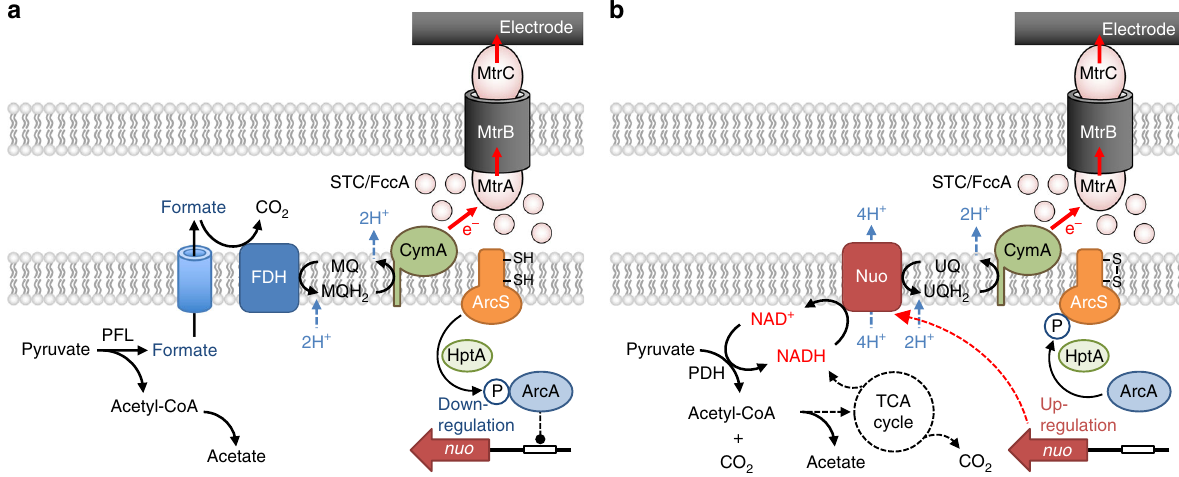
Fig. 8 Pathways for EET-associated pyruvate catabolism in S. oneidensis MR-1. a Formate-dependent catabolic pathway consisting of PFL and FDH. b NADH-dependent catabolic pathway consisting of PDH and NDH. MQ, oxidized form of menaquinone, MQH 2 reduced form of menaquinone, UQ oxidized form of ubiquinone, UQH 2 reduced form of